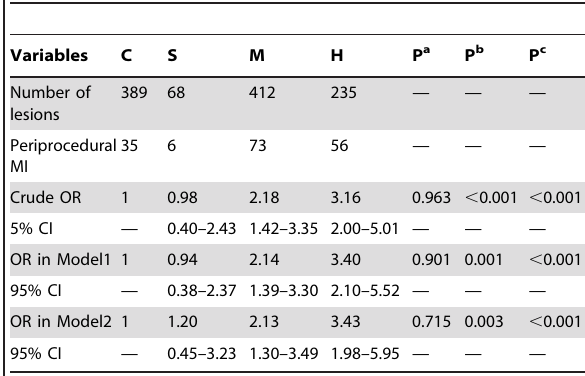
Table 4. Logistic regression analysis of the effect of calcification on periprocedural myocardial infarction according to the morphology of target lesion calcium.